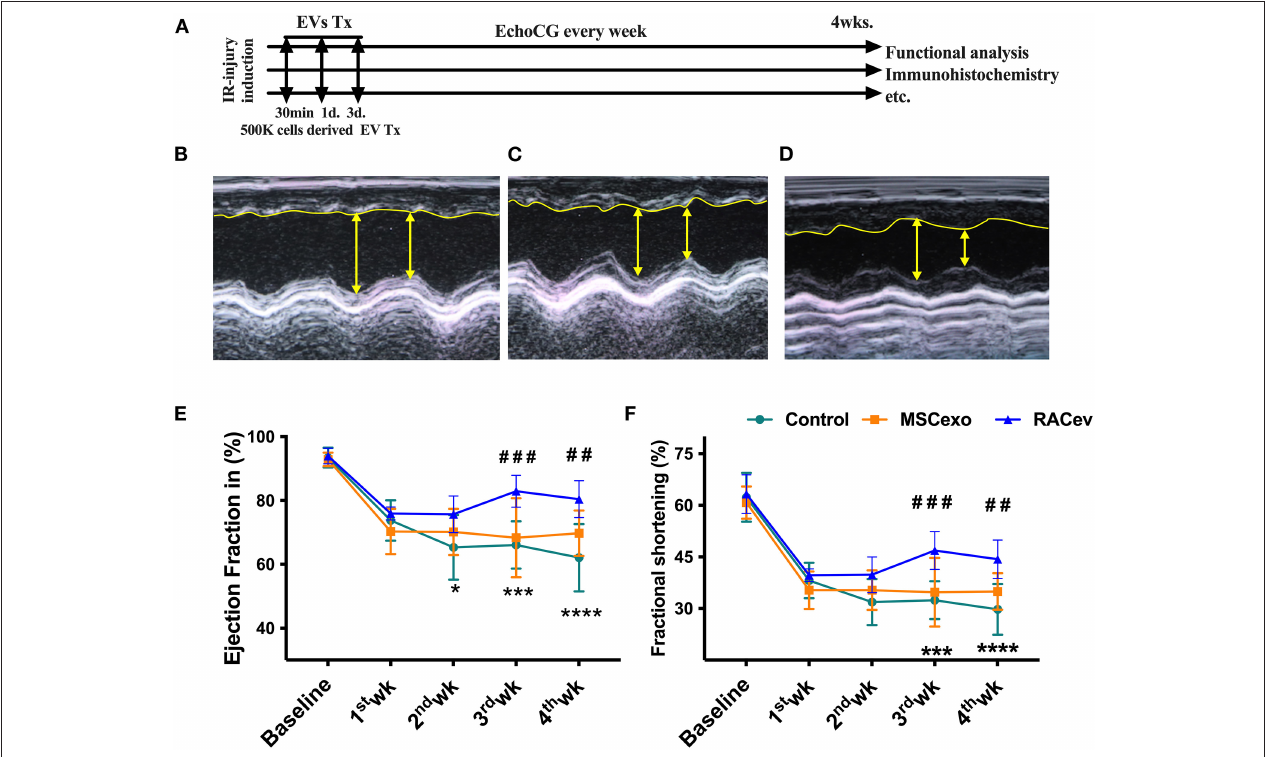
FIGURE 3 | RACev transplantation improved cardiac function. (A) Schematic of in vivo experiment design. (B–D) Representative echocardiographic images of the Control, MSCev, and RACev groups. (E,F) The RACev transplanted group showed preserved ejection fraction and fractional shortening at 4 weeks. * P < 0.05; *** P < 0.001; **** P < 0.0001 vs. the Control group; ## P < 0.01; ### P < 0.001 vs. the MSCev group. Scale bar = 100 µ m Statistical significance was determined using 2-way ANOVA followed by Tukey’s multiple comparison post-hoc test. The results are presented as mean ± SEM. ( n = 8–10 per group). EchoCG,